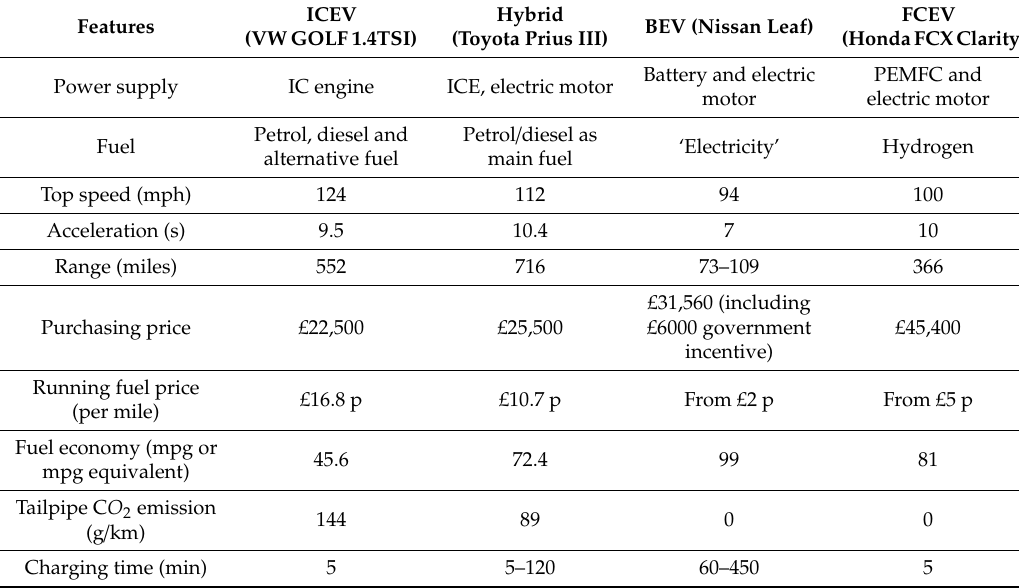
Table 7. Comparison of vehicle specifications. Adapted from